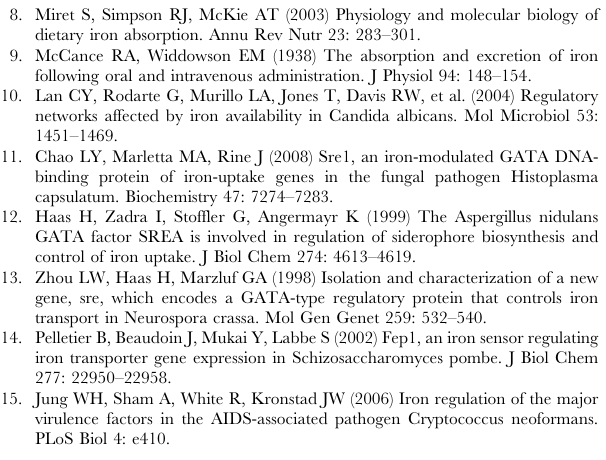
(anti-PAP) that recognizes a portion of Protein A. Input, Flow Through (FT), and Eluate designations correspond to fractions depicted in (b). Note that TAP peptides are not visible in Eluate fractions because cleavage with TEV protease liberates only the